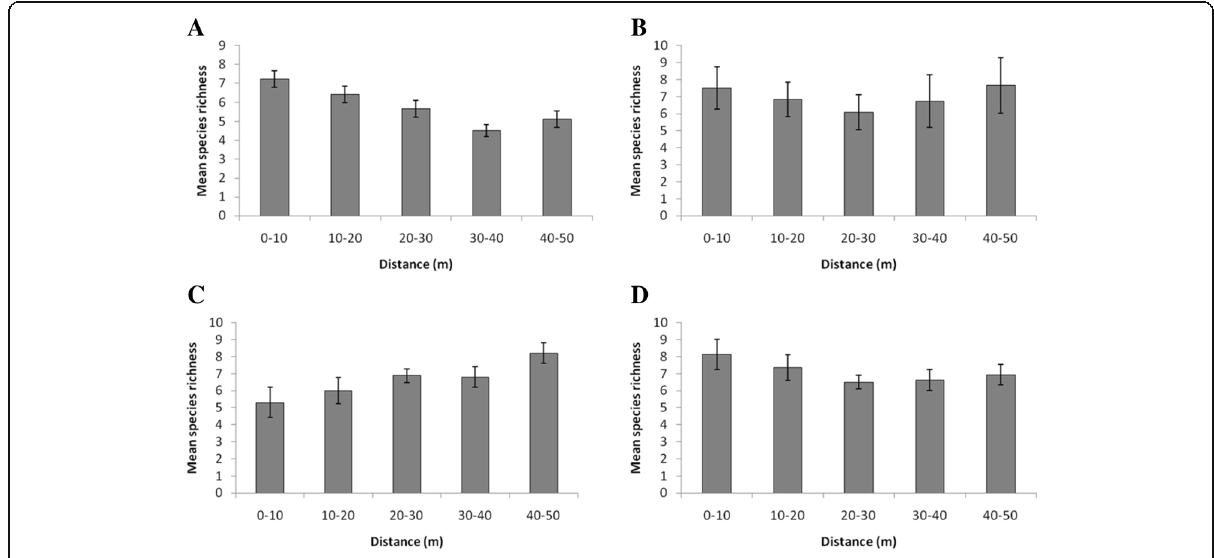
Fig. 4 Mean species richness with distance from surface water in Boro ( a ), Seronga ( b ), Jao ( c ), and UPH ( d )